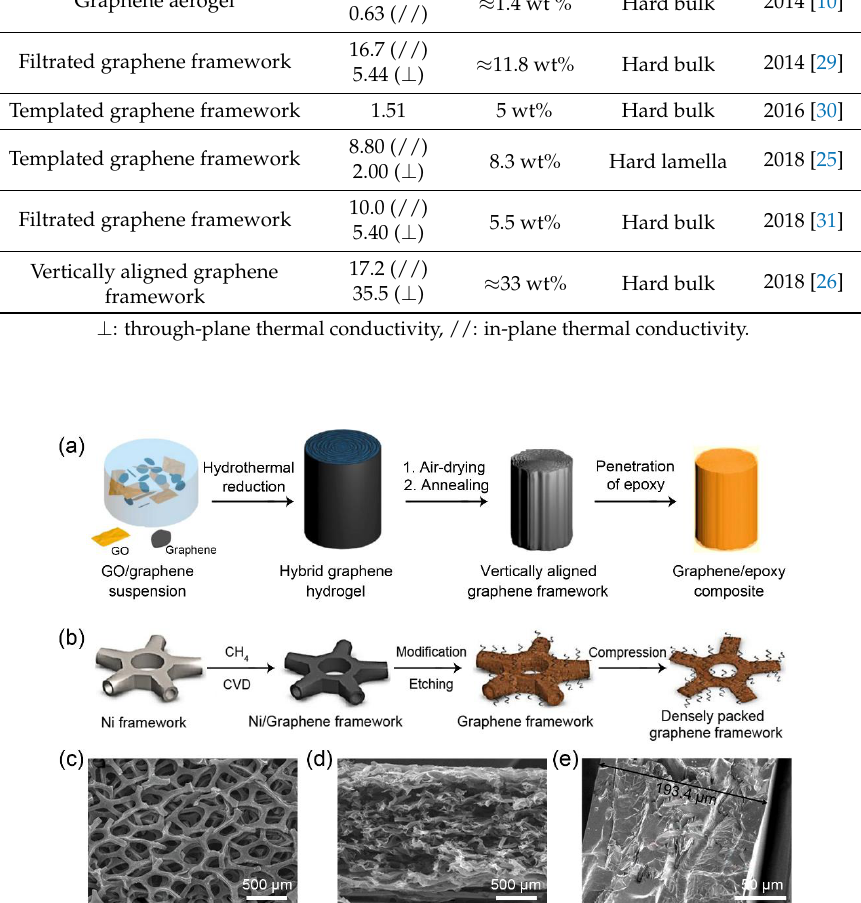
Figure 3. ( a ) Schematic illustrating the self-assembly method to fabricate the densely packed